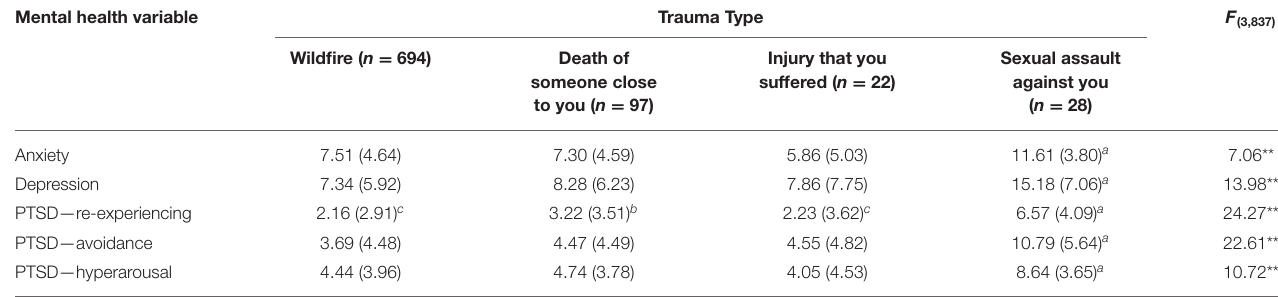
TABLE 4 | Means (SD) of mental health variables and MANCOVA results of differences between different types of trauma, while controlling for age and